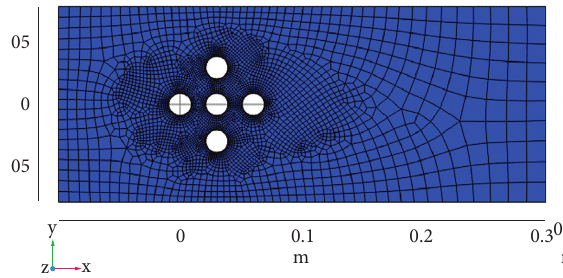
Figure 21: XY section